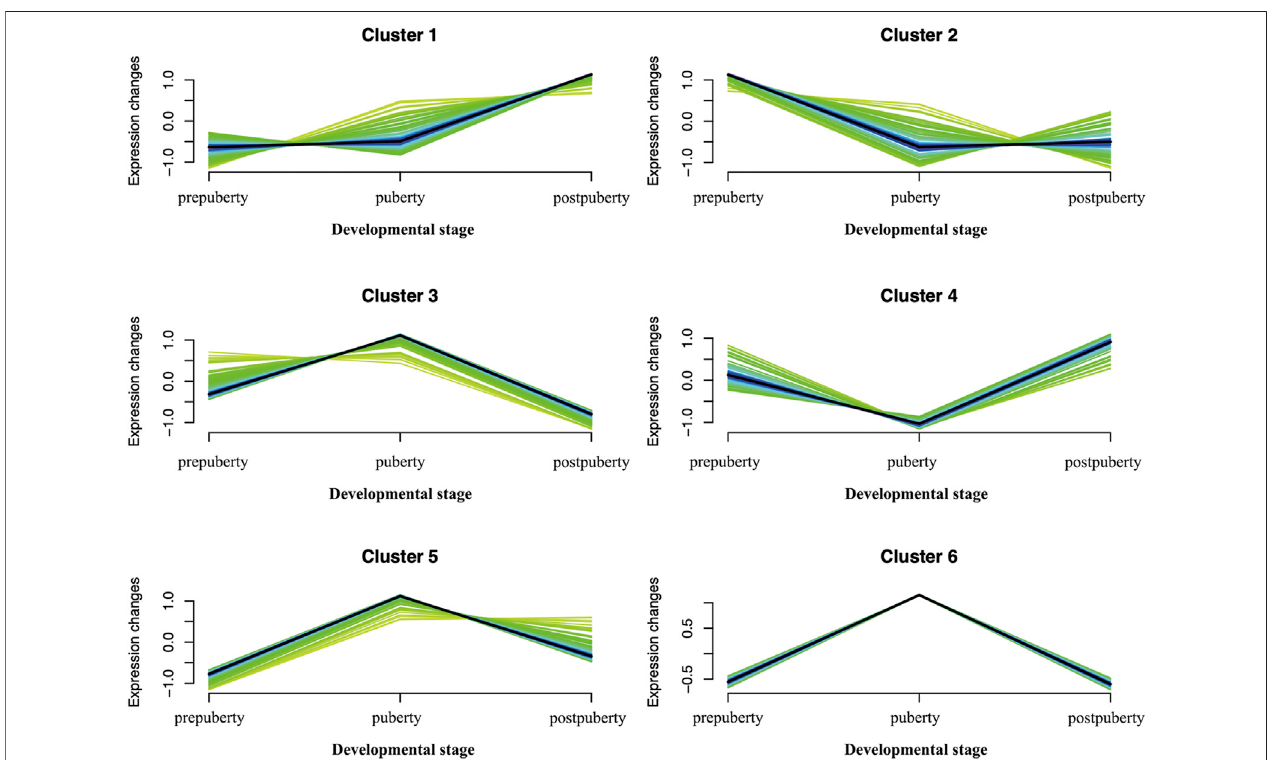
FIGURE 9 | Soft clusters of differently expressed genes. Twelve puberty-related clusters. The horizontal axis represents the different developmental stages (prepuberty, puberty, and postpuberty). The vertical axis represents the changes in expression.